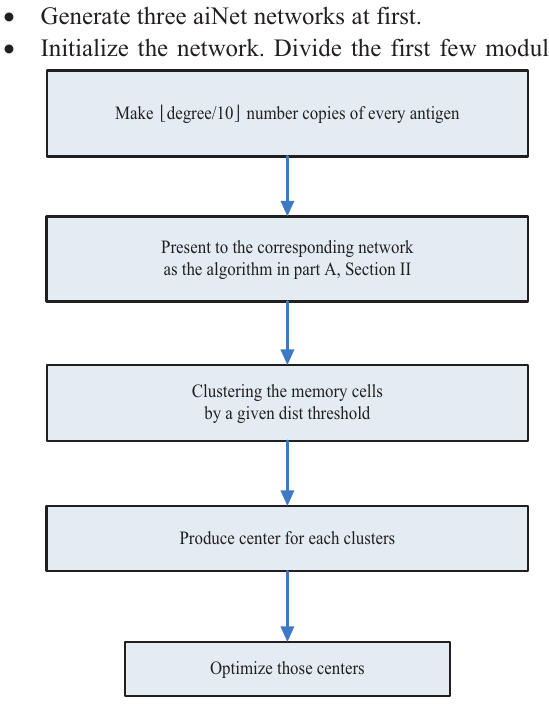
Fig. 4. Network adjust